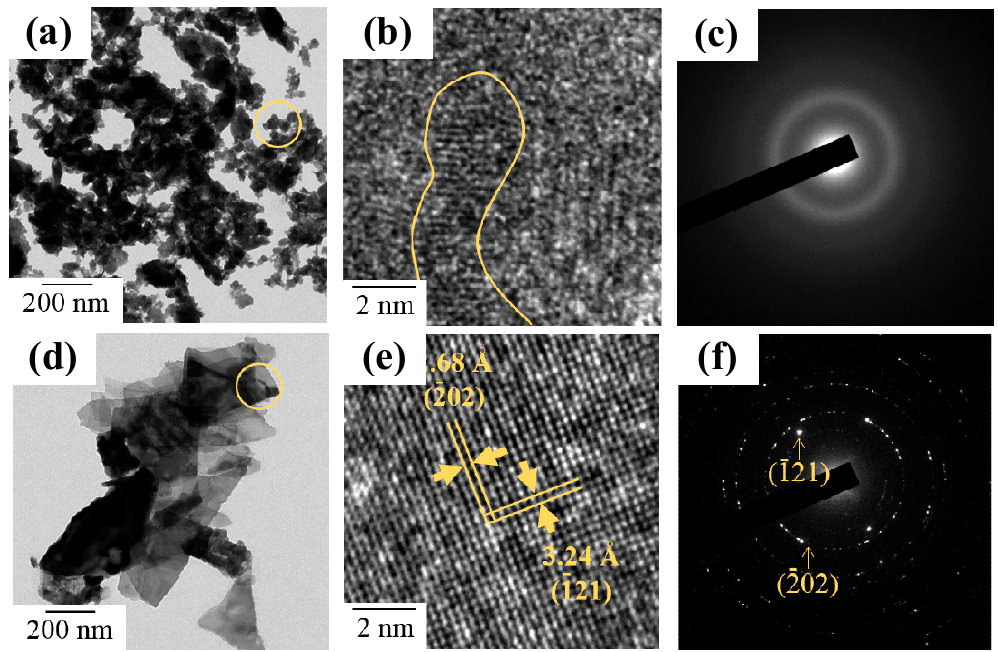
Figure 4. TEM images of sol-gel Bi 2 O 3 powders ( a ) before and ( d ) after 500 °C heat treatment. ( b , e ) HRTEM images; and ( c , f ) selected area diffraction pattern (SAED) taken from the circled area in ( a , d ), respectively.